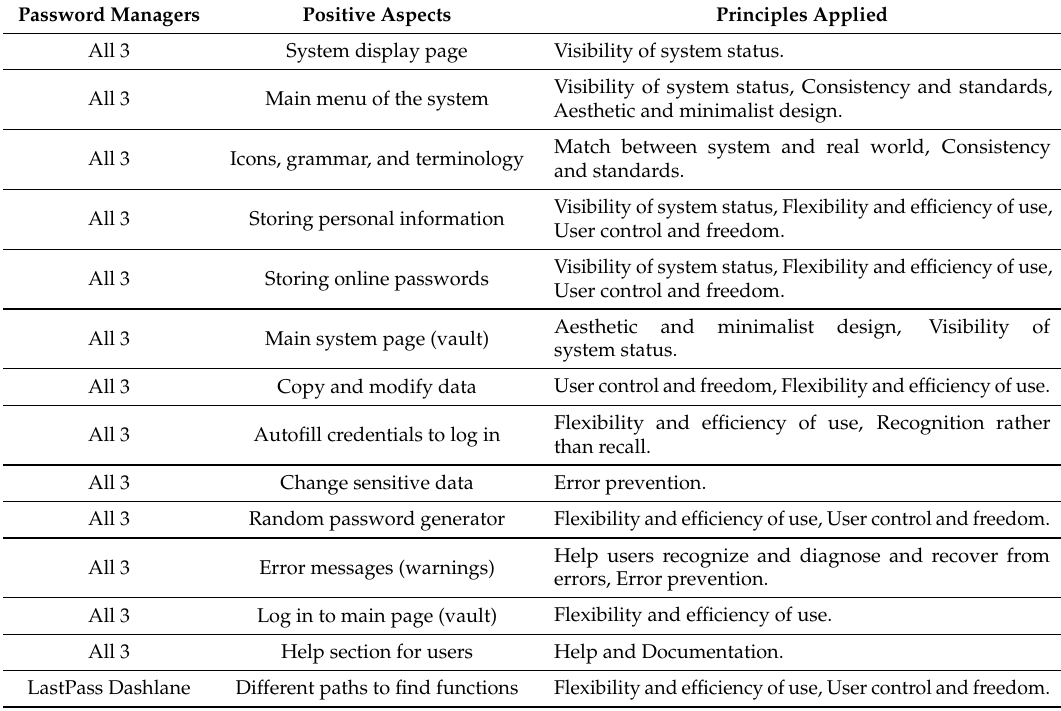
Table 6. Positive aspects and Nielsen’s principles applied to three cloud password managers. Explanation of positive aspects can be found in the Appendix